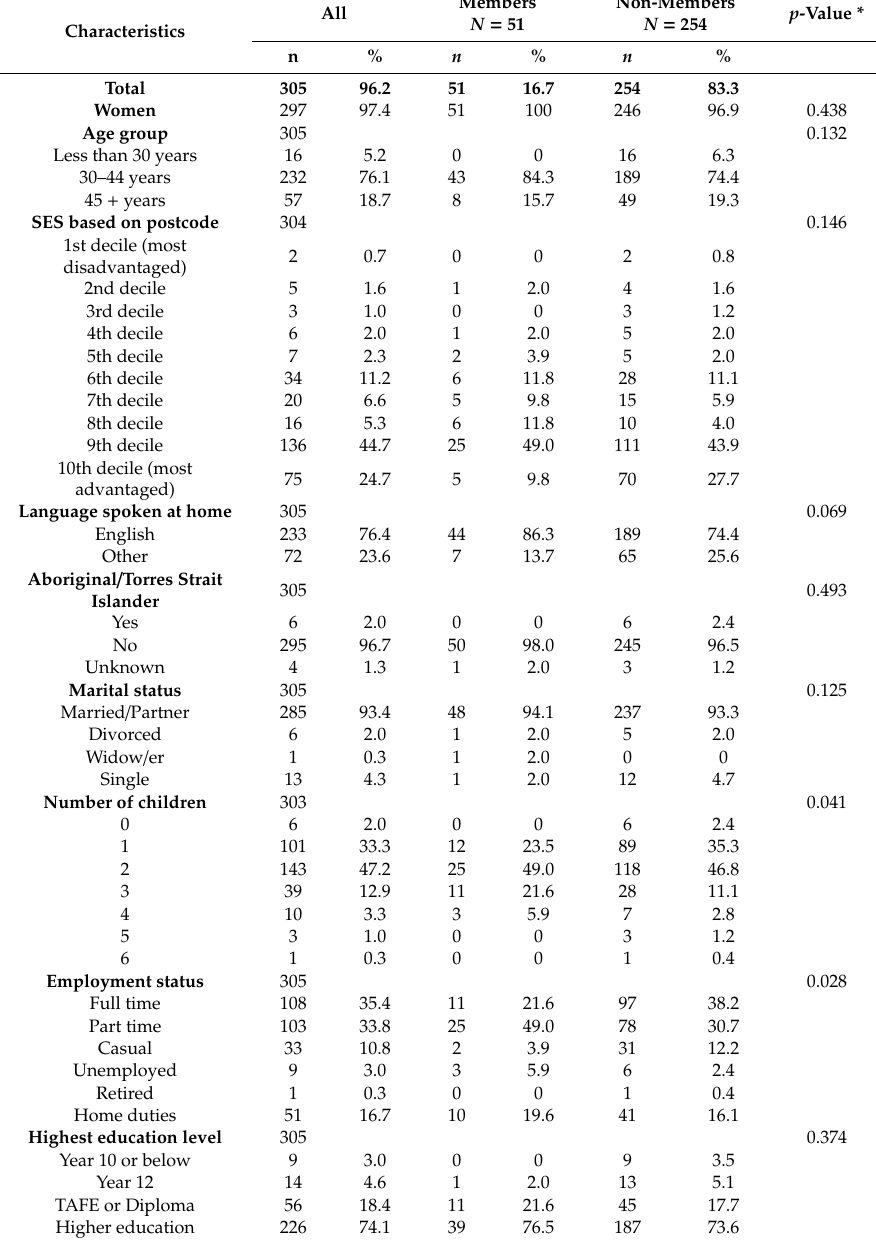
Table 2. Socio-demographic characteristics of food co-op members and